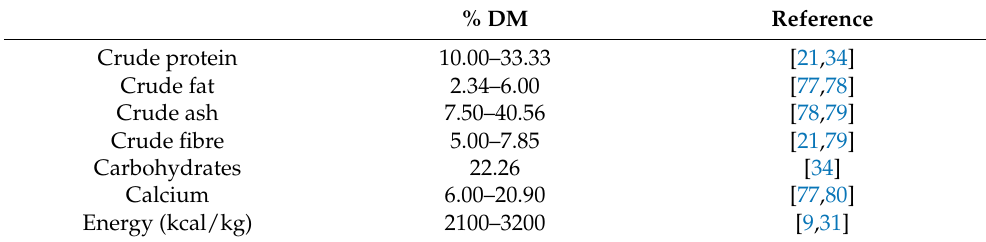
Table 6. Examples of feed mixtures used in feeding land edible snails are shown in Table 7. Table 6. The proportion of nutrients used in feed mixtures for edible land